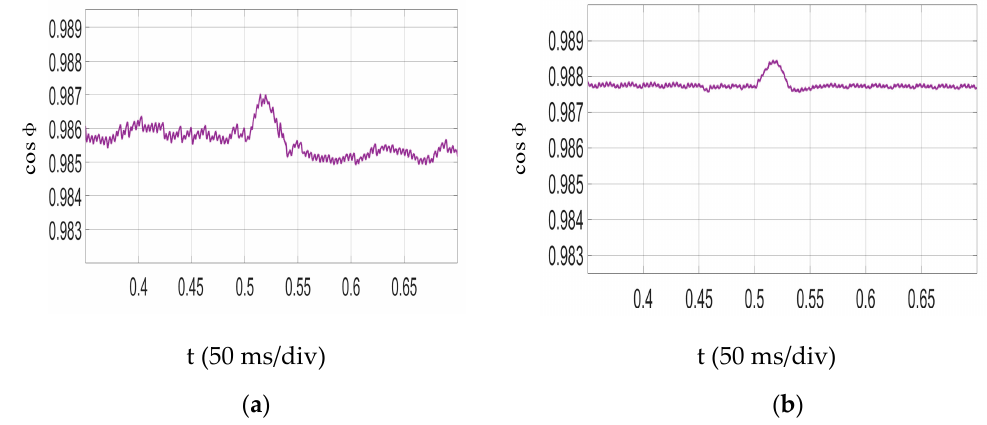
Figure 14. Power factor of AC input side when the load suddenly increases: ( a ) controlled by back- stepping control method; ( b ) controlled by SMVS. backstepping control method; ( b ) controlled by